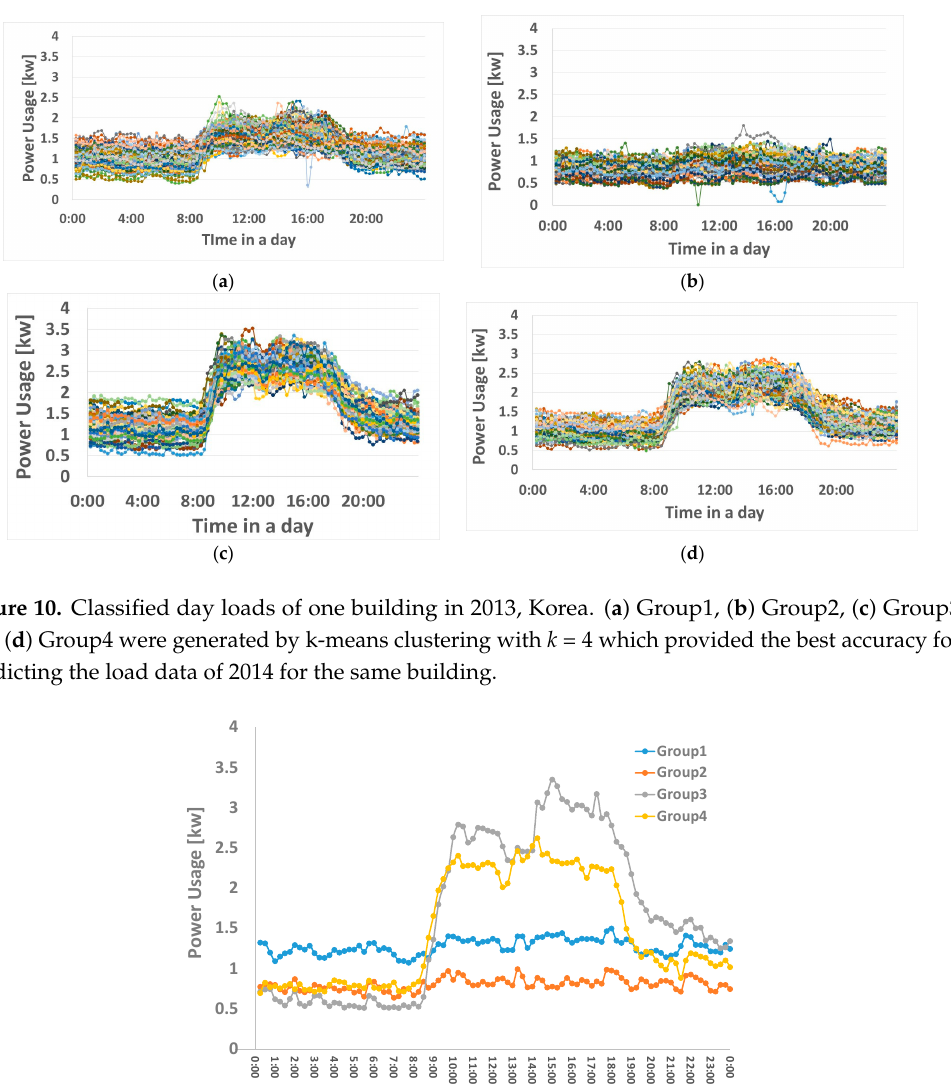
Figure 11. Representative load patterns from each group classified by k-means classification.